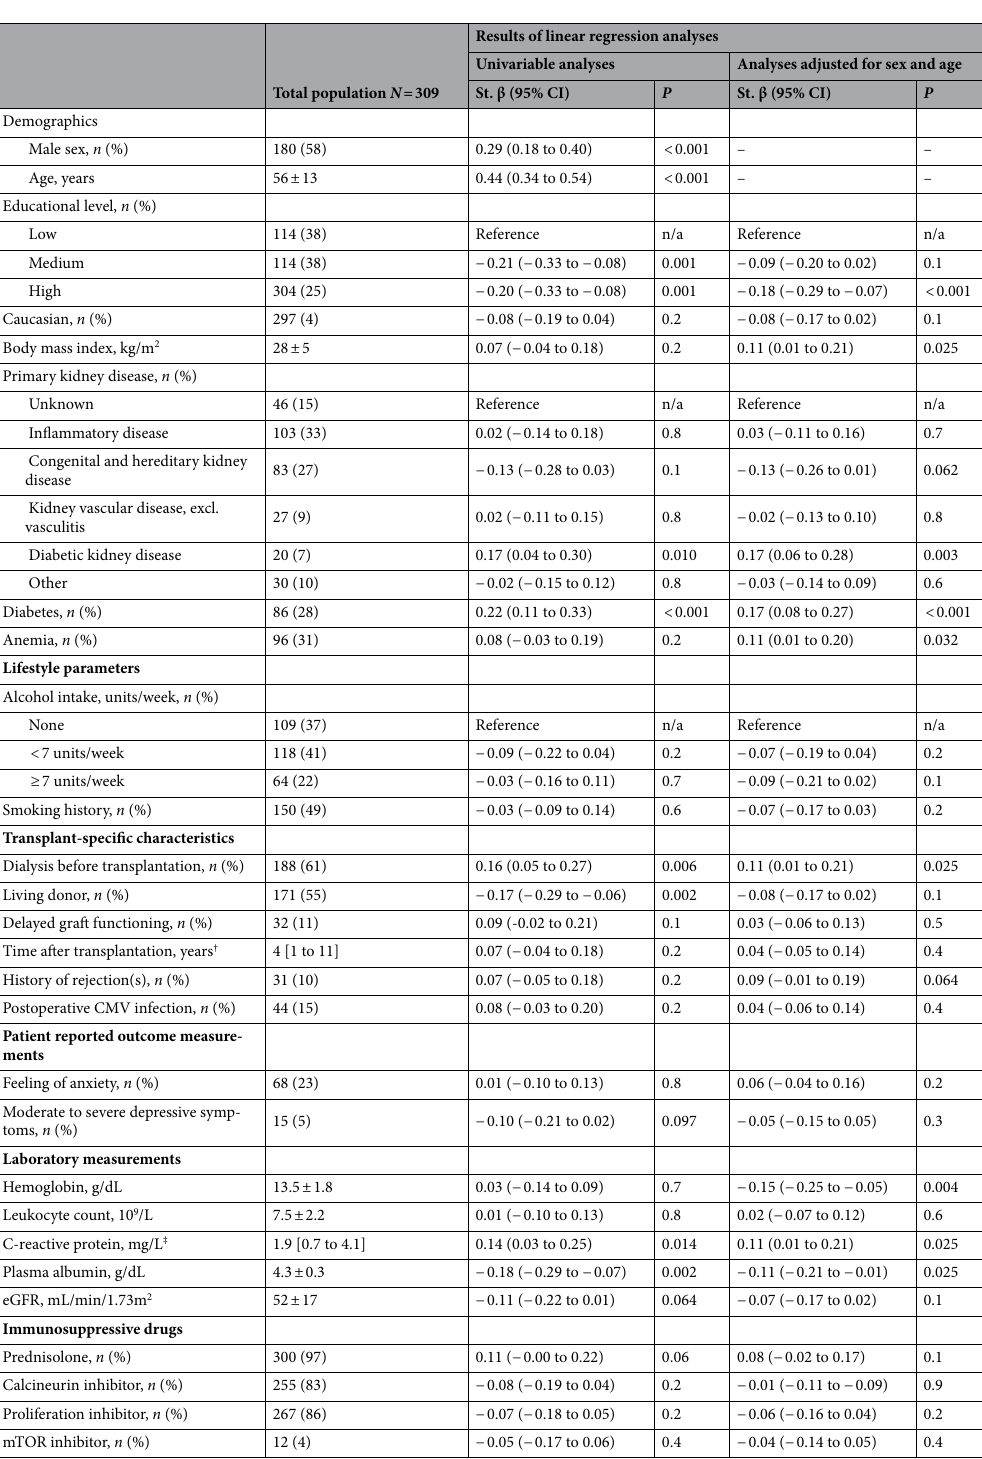
Table 1. Baseline characteristics and associations with hand dexterity. Normally distributed data are presented as mean ± standard deviation, non-normally distributed data as median [interquartile range], and categorical data as number (valid %). † : Variables were log 2 transformed to meet assumptions of linear regression analyses. Higher positive standardized beta coefficients indicate slower performance of the 9-hole peg test, and hence worse hand dexterity. Data regarding educational level, alcohol intake, smoking history, history of rejection, postoperative CMV infection, feeling of anxiety and moderate to severe depressive symptoms, were missing in 5 (2%), 18 (6%), 1 (0.3%), 7 (2%), 10 (3%), 7 (2%) and 8 (3%) participants, respectively. Abbreviations: CI, confidence interval; CMV, cytomegalovirus; eGFR, estimated glomerular filtration rate; mTOR, mammalian target of rapamycin; St. β, standardized